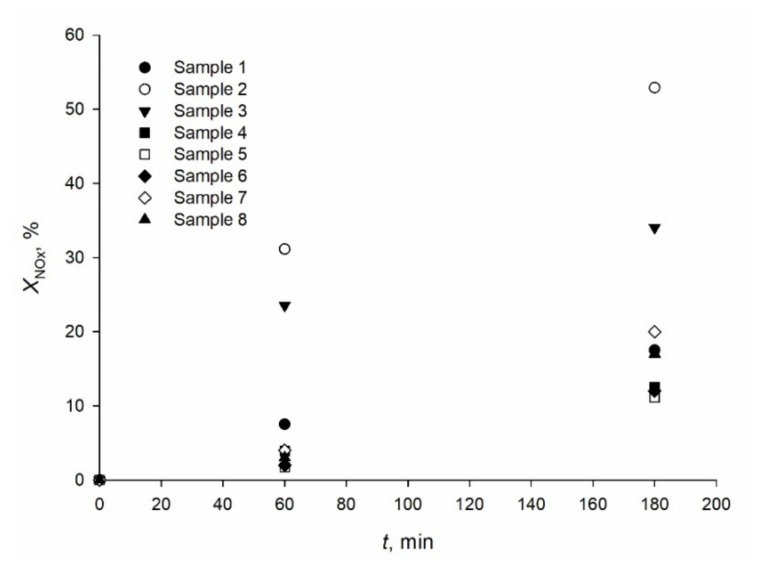
Figure 6. NOx degradation for sample 1–8 versus time.